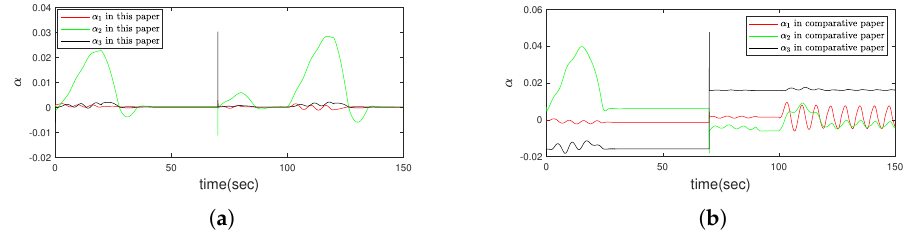
Figure 6. ( a ) The response curves for sliding mode surface α in this paper. ( b ) The contrastive curves for sliding mode surface α in method that ignores the effect of thruster saturation in [15].